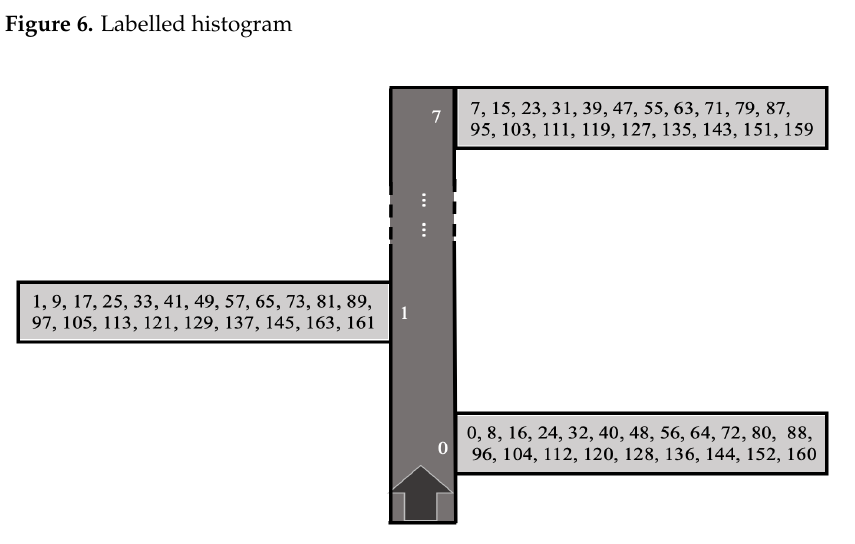
Figure 7. A one-dimensional visualization of reverse engineering the toy